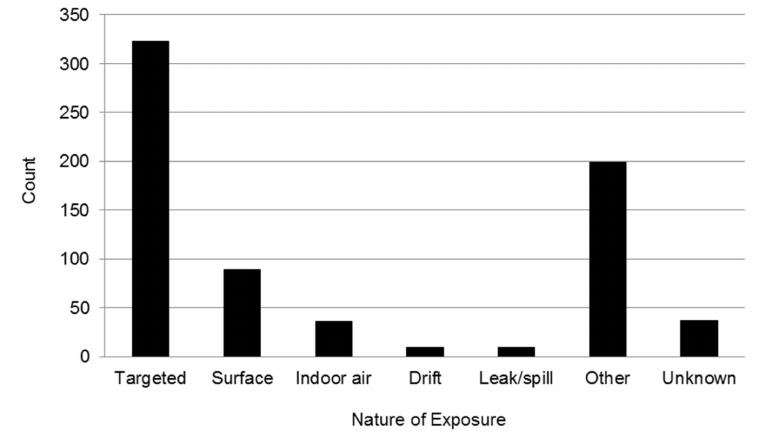
Figure 3. Distribution of events in childhood reported by nature of exposure (some exposures classified into more than one